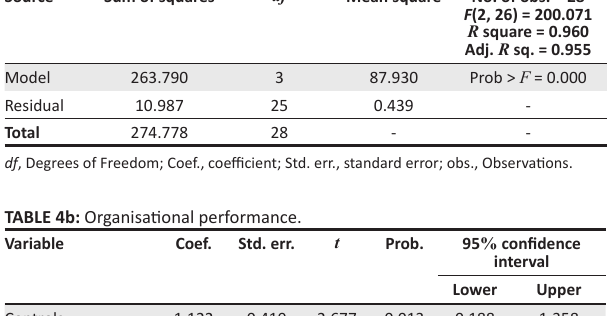
Corporate Organisational implementation controls performance